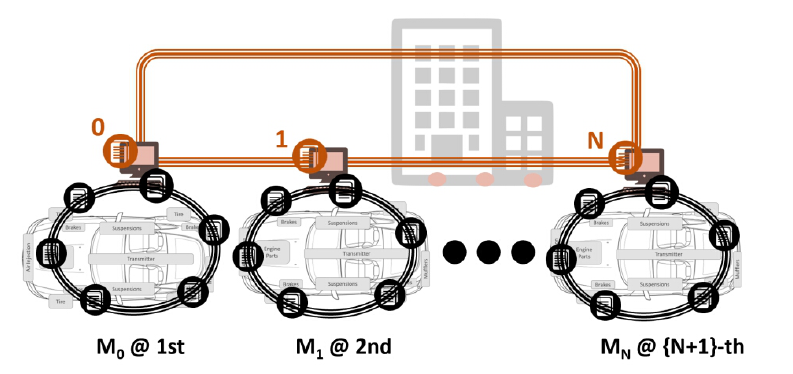
Figure 3. IoT-Server network architecture in the MLBGG. M k ( k = 0, 1, 2, ... N ) is the index which is started from 0 and N + 1 is the total count of